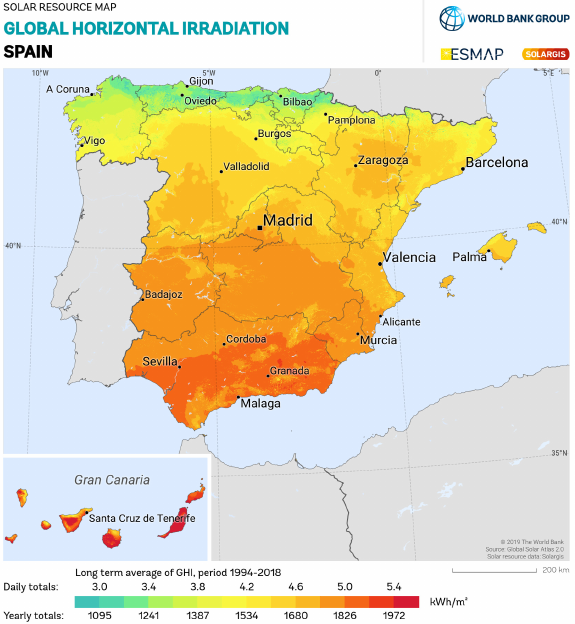
Figure 2. Global irradiance map for horizontal surface in Spain